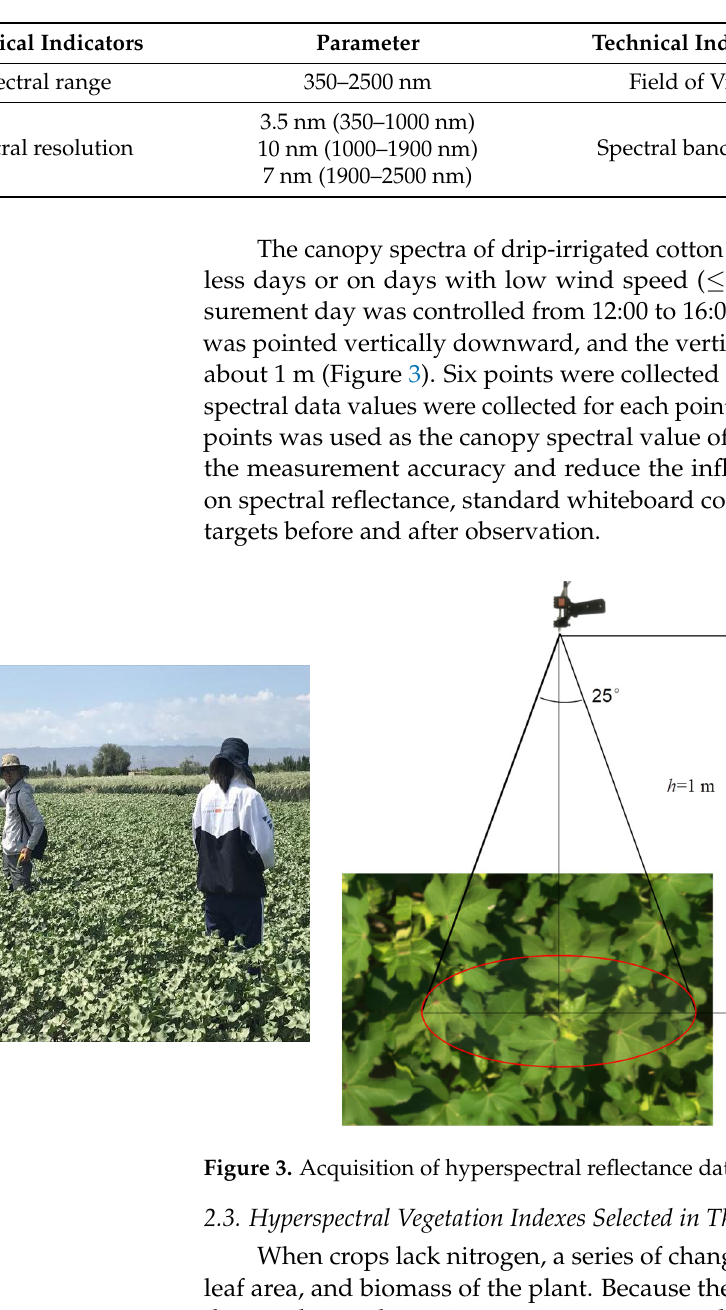
Table 4 . List of hyperspectral vegetation indexes used in this study .